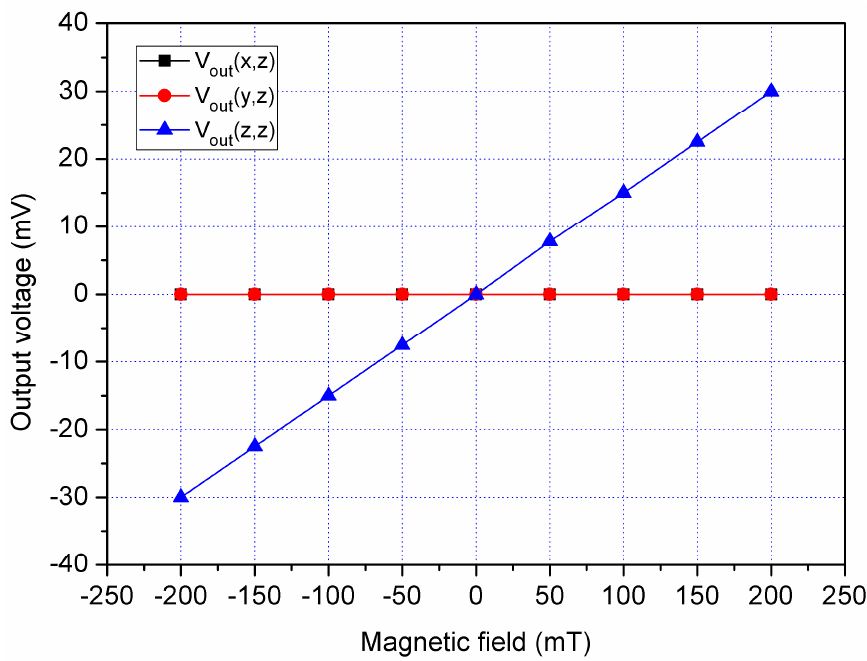
Figure 7. Simulation of output for the MS in the y-direction MF.